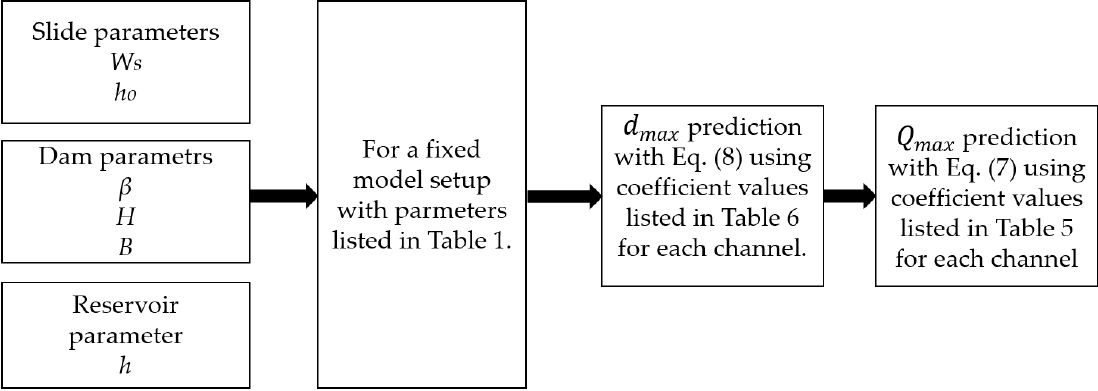
Figure 13. Flow chart showing the proposed calculation procedure for the overtopping discharge.